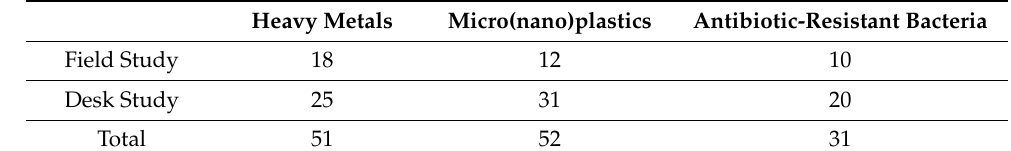
Table 2. The total number of reviewed field and desk studies.